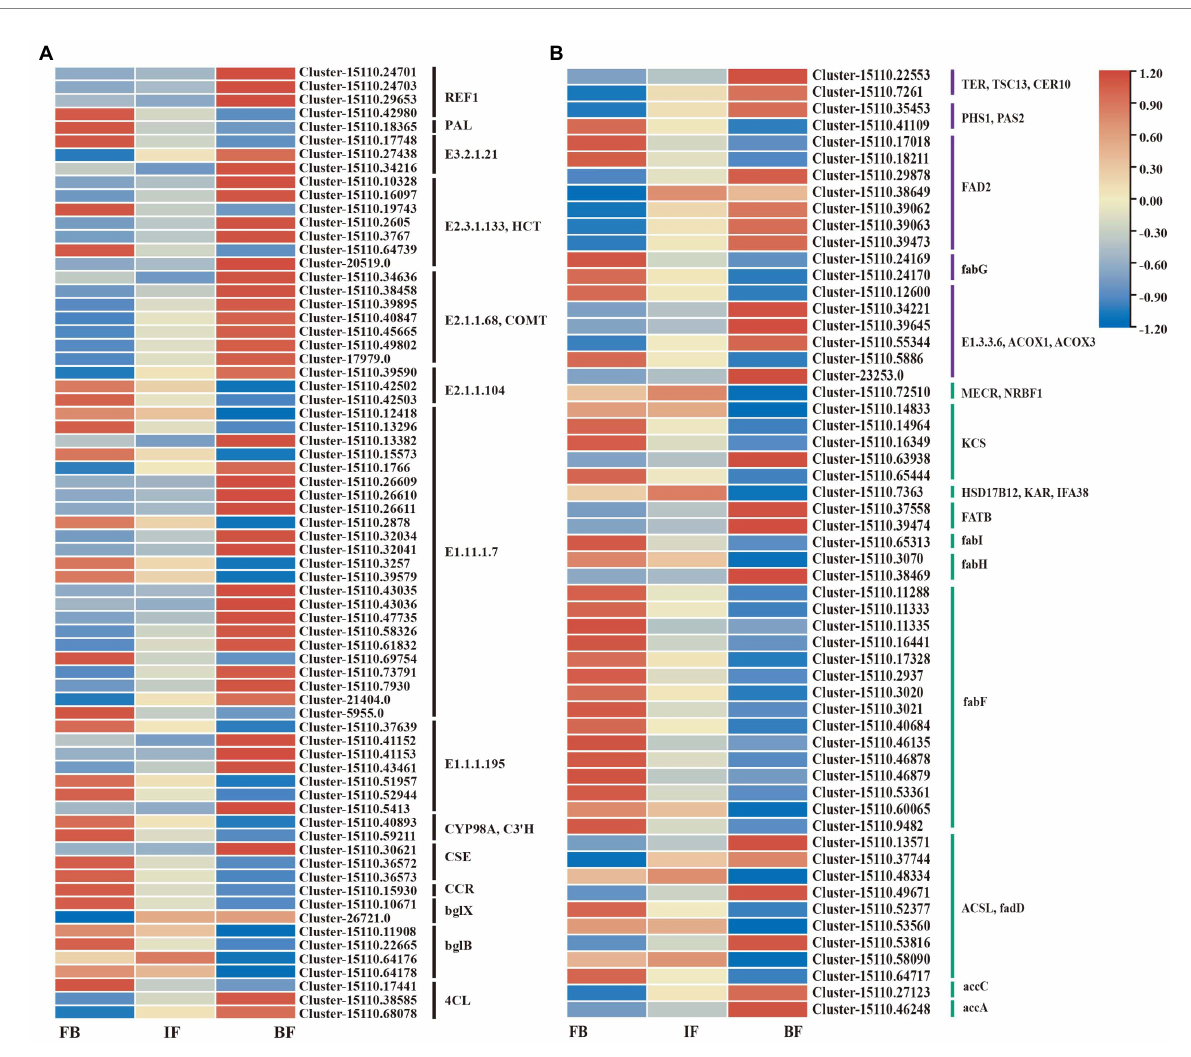
FIGURE 6 Expression heatmaps of candidate genes involved in volatile metabolite biosynthesis in flowers of Chrysanthemum indicum var. aromaticum . (A) Phenylpropanoid-related pathway. (B) Ester metabolic pathway (purple and green).